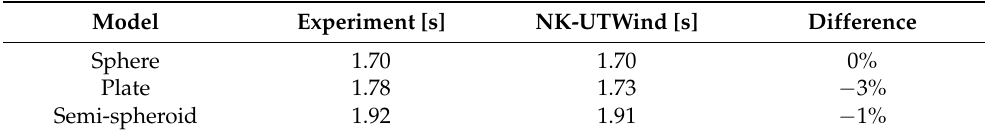
Table 8. The most energetic vibration mode obtained from the hammering test. Model